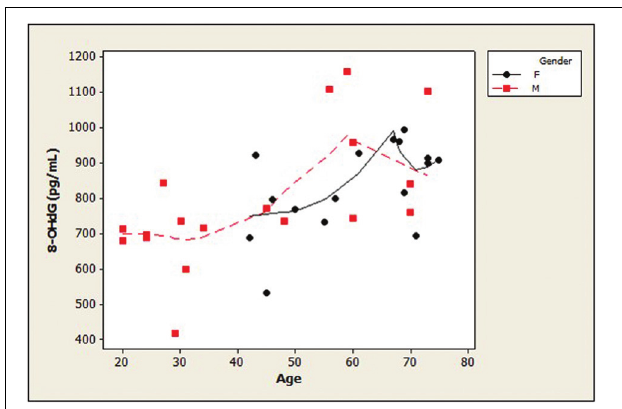
FIGURE 2 | Distribution of CSF concentrations of 8-OHdG as a function of age in healthy adults. Age and 8-OHdG were strongly positively associated ( ρ = 0.61; p = 0.0001). 8-OHdG levels tended to increase with age with similar patterns for both genders. (dashed lines, men; solid lines, women; 8-OHdG, 8-hydroxy-2 (cid:48)